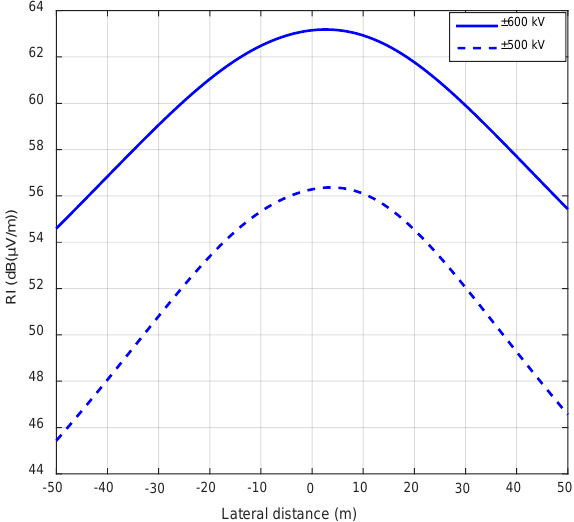
Figure 4. RI lateral profiles of the two HVDC transmission lines.